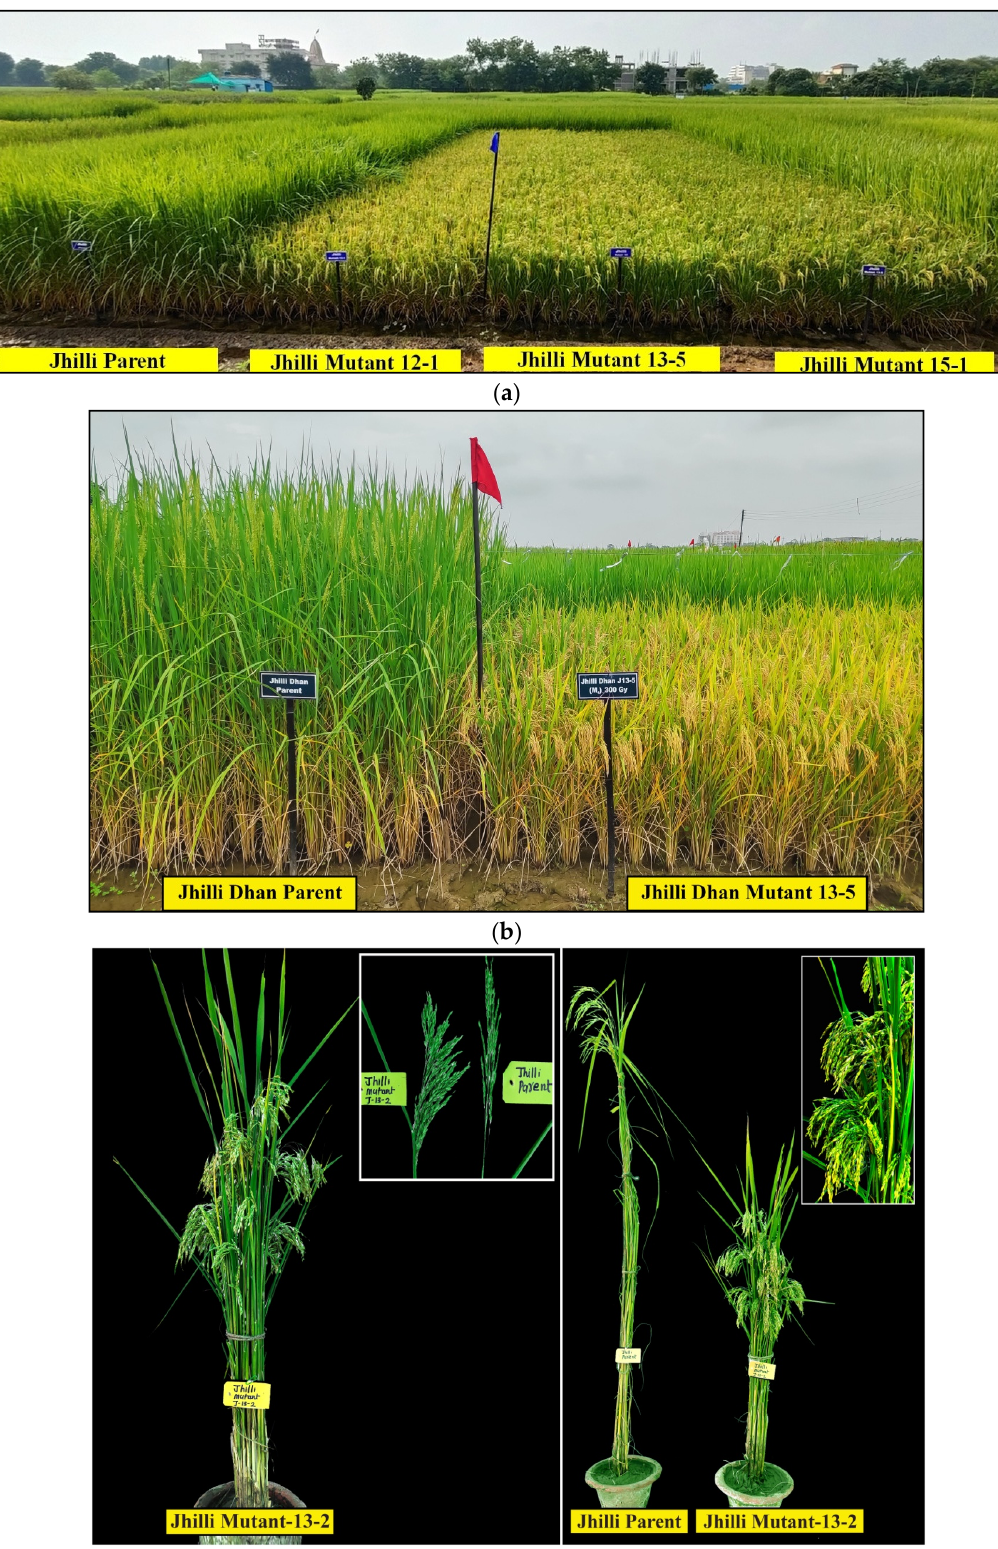
Figure 7. ( a ) Comparative field view of promising Jhilli Mutant 12-1, Jhilli Mutant 13-5 and Jhilli Mutant 15-1 with Jhilli parent. ( b ) Comparative field view of promising Jhilli Mutant 13-5 with the Jhilli parent. ( c ) Representation of Jhilli Mutant 13-2 having clustered grains.